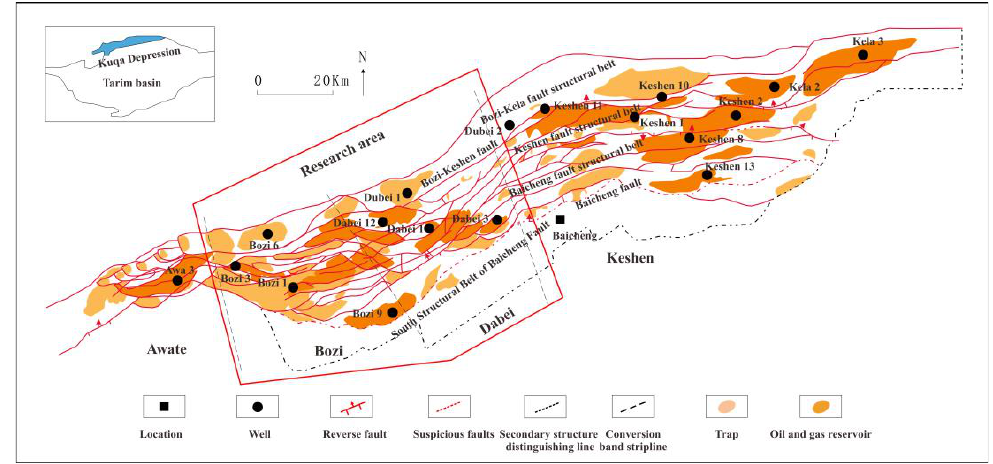
Figure 1. Fault Outline Map of Kelasu Structural Belt.